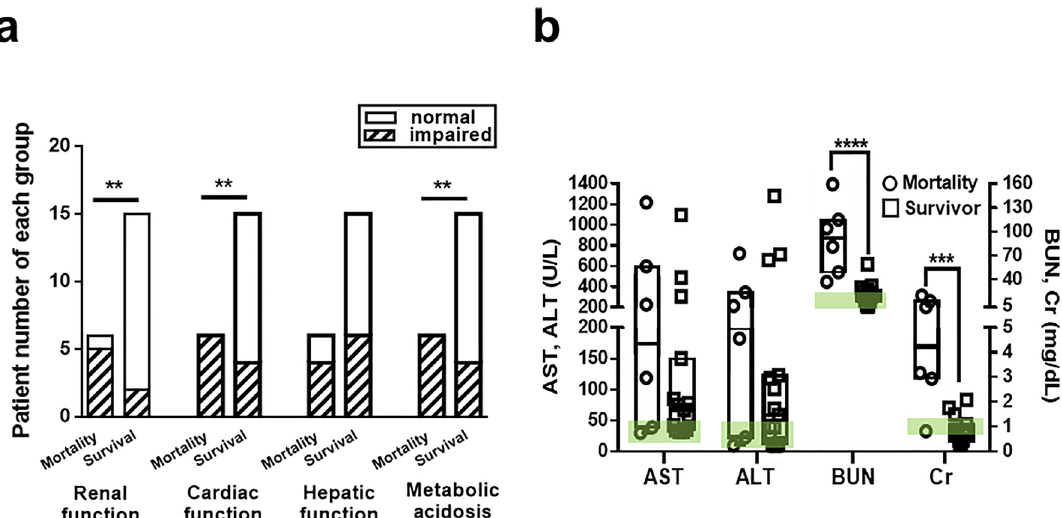
Figure 4. Multisystem complications in patients with SRSE. ( a ) Numbers of patients with renal, cardiac, or hepatic dysfunction or metabolic acidosis in the mortality and survival groups. ( b ) Comparisons of AST, ALT, BUN, and Cr in both groups. ** p < 0.01. SRSE super-refractory status epilepticus, BUN blood urea nitrogen, Cr creatinine, AST aspartate aminotransferase, ALT alanine aminotransferase. Dark lines indicate median values, and boxes indicate interquartile ranges; the green band presenting normal ranges for BUN, Cr, AST, ALT, respectively in ( b